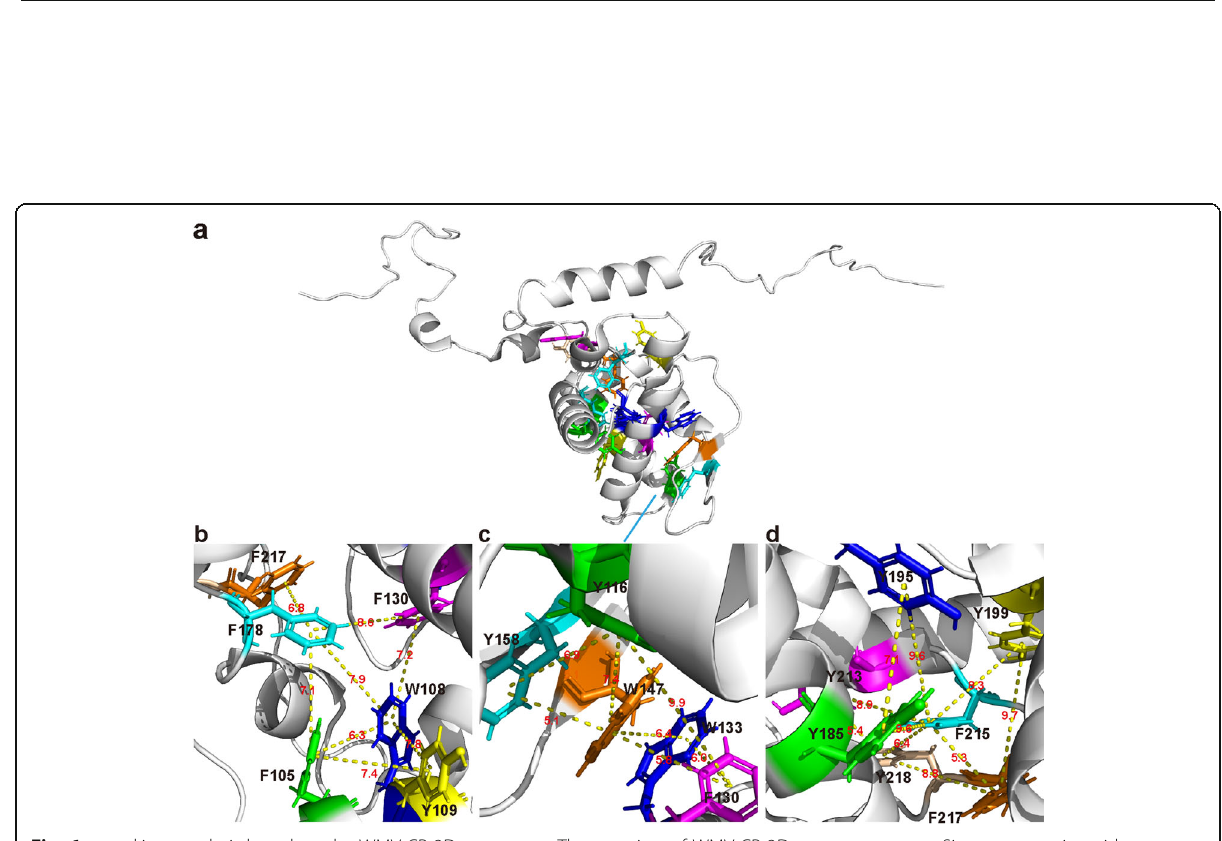
Fig. 6 π -stackings analysis based on the WMV CP 3D structure. a The overview of WMV CP 3D cartoon structure. Sixteen aromatic residues forming π -stackings are shown in sticks. b – d The close views of the π -stackings between 16 aromatic residues in WMV CP. The positions of F 105 , W 108 , Y 109 , F 130 , F 178 and F 217 indicated with different colors are shown in b . The positions of Y 116 , F 130 , W 133 , W 147 and Y 158 indicated with different colors are shown in c . The positions of Y 185 , Y 195 , Y 199 , Y 213 , F 215 , F 217 and Y 218 indicated with different colors are shown in d . The centroid distance less than 10 Å between two aromatic rings is indicated with a yellow dash line and the corresponding distance values are indicated with red